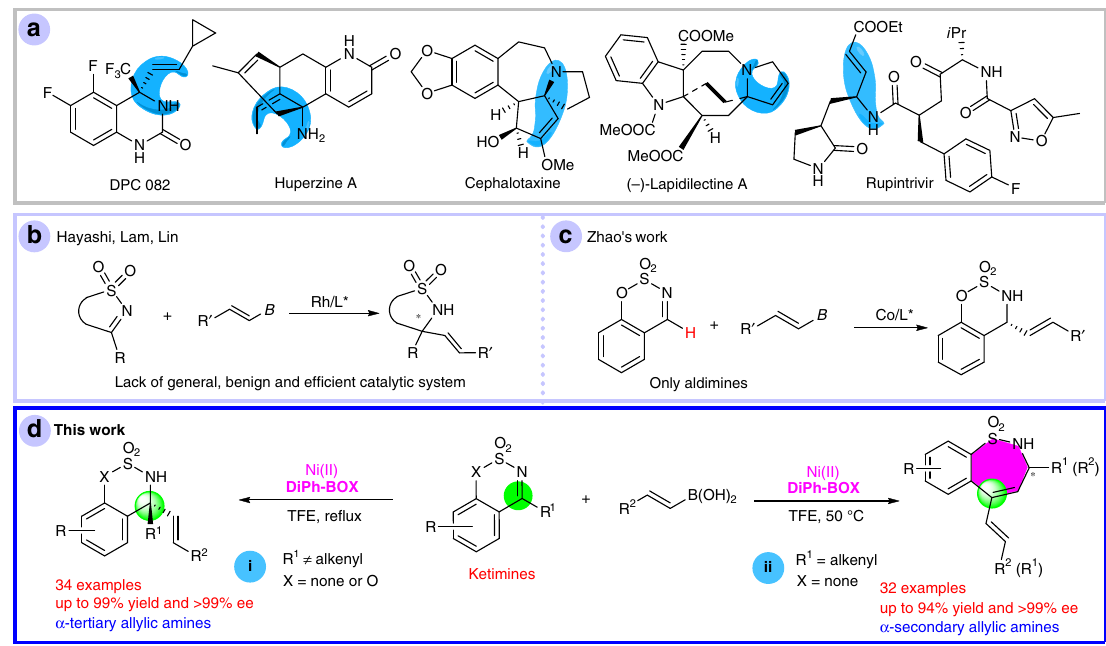
Fig. 1 Addition of alkenylborons to imines for construction of chiral allylic amines. a Representative bioactive chiral allylic amines. b Rh-catalyzed addition of alkenylborons to ketimine. c Co-catalyzed addition of alkenylborons to aldimine. d This work: a general Ni(II)/BOX-catalyzed alkenylation and alkenylation/ ring-expansion of cyclic ketimines. BOX =